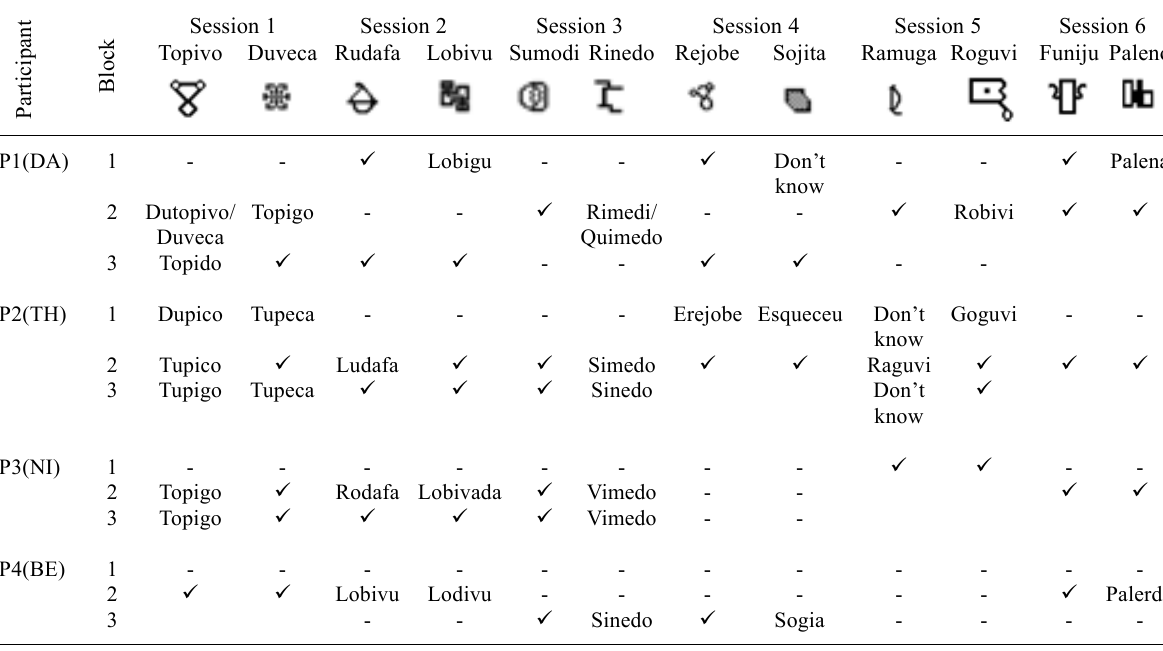
Naming of thePictures for the Participants of Study 1. Tics Indicate Correct Naming Responses; Dashes Indicate that the Naming Block was not Performed; Words Indicate Incorrect